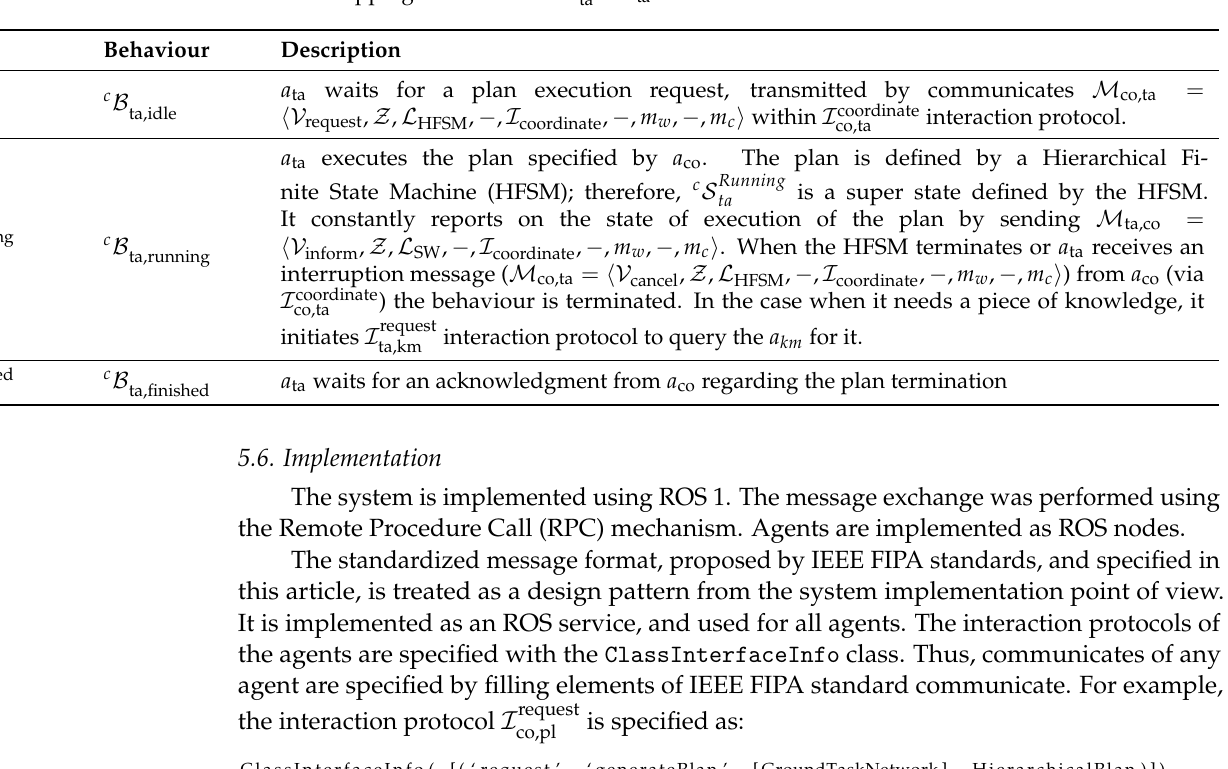
Table 6. Mapping of the states of c ta to a ta